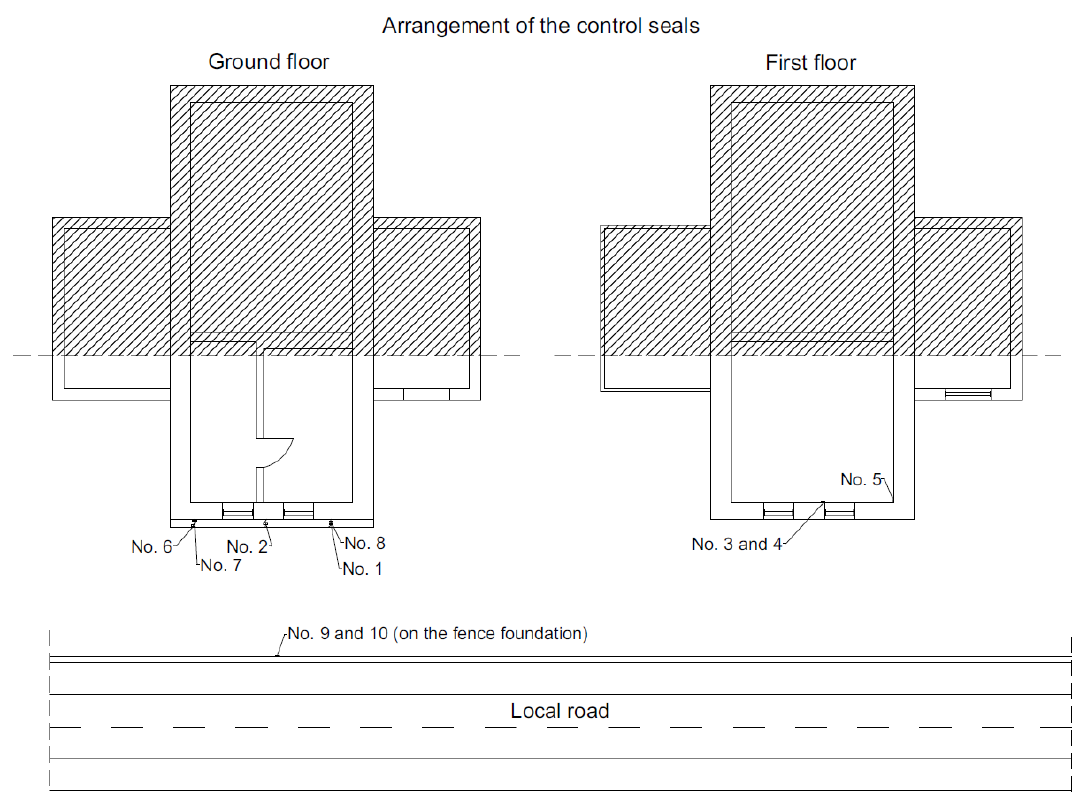
Figure 2. Arrangement of gypsum control tapes.